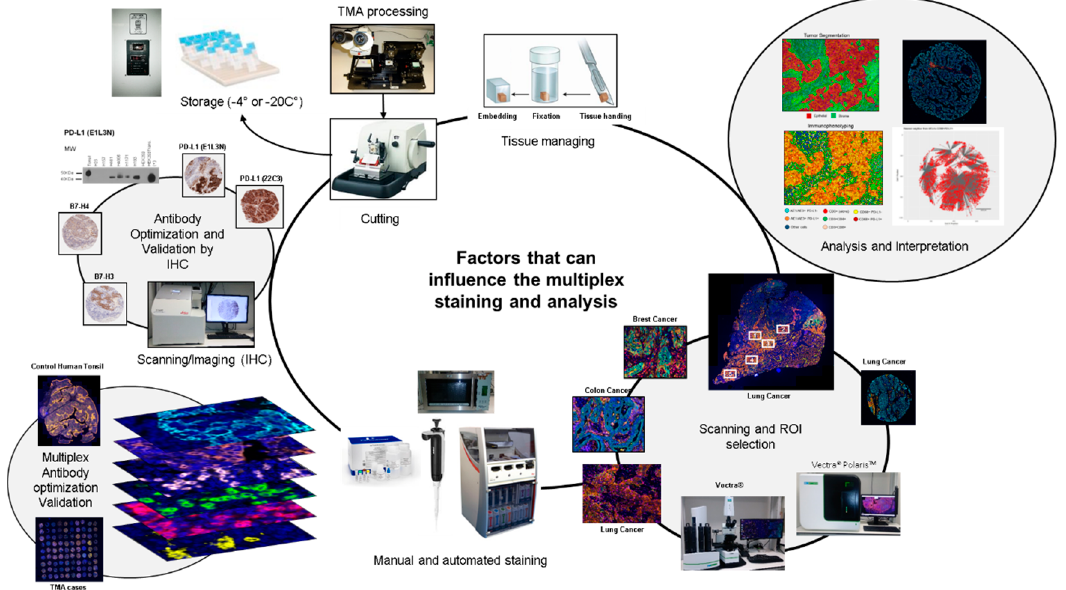
Figure 1. Factors that can influence multiplex image staining and analysis. Digital image analysis platforms can be influenced by factors related to tissue processing and handling, including cutting and storage. Antibody optimization and validation by immunohistochemistry (IHC), immunofluorescence (IF), and multiplex IF as well as staining, scanning and analysis procedures must be standardized to obtain accurate data.